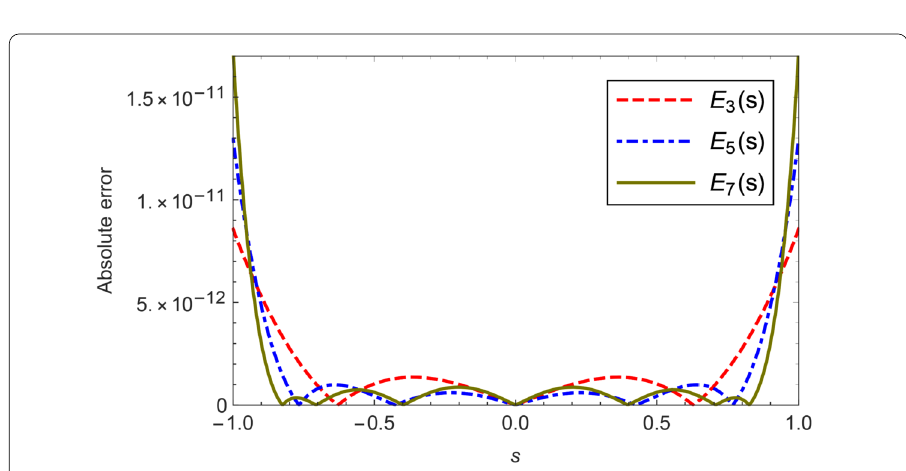
Figure 1 Comparison of solutions for Example 1 with n = 7 and m = 16